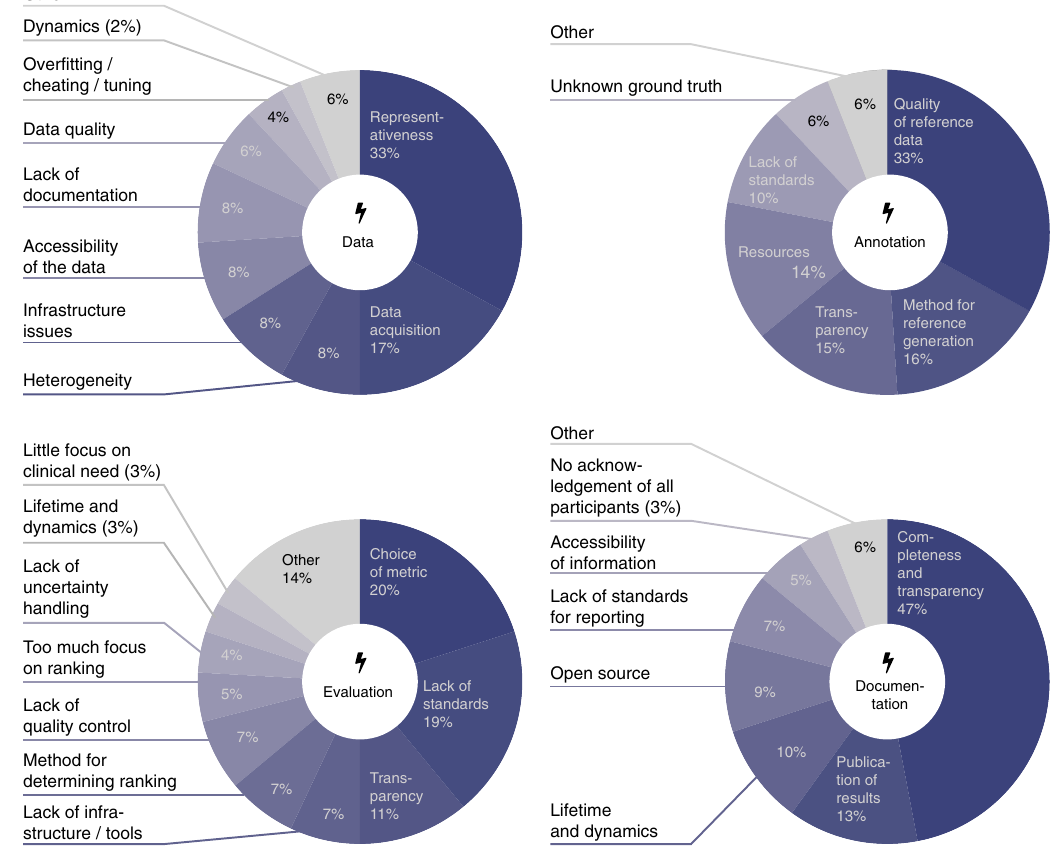
Fig. 5 Main results of the international questionnaire on biomedical challenges. Issues raised by the participants were related to the challenge data, the data annotation, the evaluation (including choice of metrics and ranking schemes) and the documentation of challenge